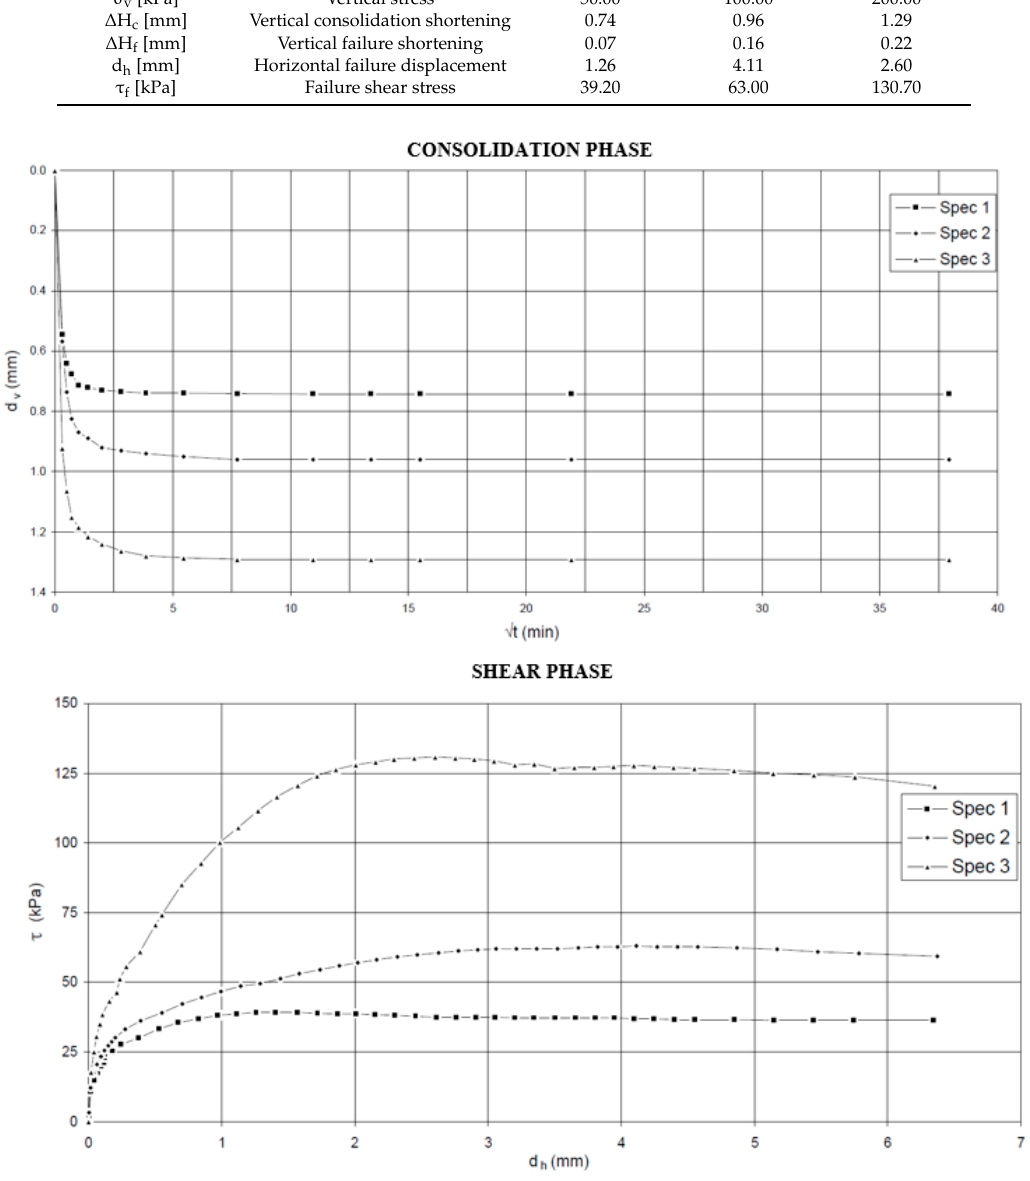
Figure 5. Consolidation and shear phases of the direct shear test.